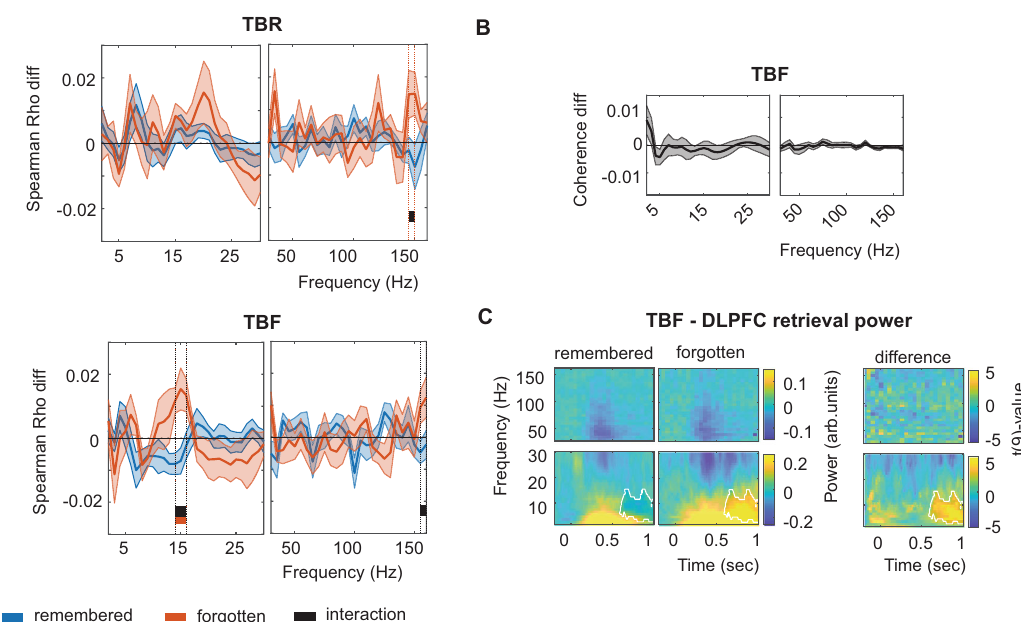
Fig. 5 Item-speci fi c encoding-retrieval similarity of connectivity patterns between DLPFC and LTC. A Encoding-retrieval similarity for all to-be- remembered (TBR; top) and to-be-forgotten (TBF; bottom) items, separately for words that were later remembered (blue) or forgotten (orange) based on dorsolateral prefrontal cortex (DLPFC) — lateral temporal cortex (LTC) coherence ( n = 10). Shaded error bars indicate the standard error of the mean. Blue, orange, and black lines indicate signi fi cant item-speci fi c encoding-retrieval similarity of remembered words, forgotten words, and their difference, respectively. B Overall DLPFC-LTC coherence difference between remembered and forgotten words. C Time-frequency responses during retrieval for DLPFC averaged across all frontal bipolar channels for TBF words. Power was signi fi cantly different in a late window as indicated by the white outline. Source data are provided as a Source Data fi le.